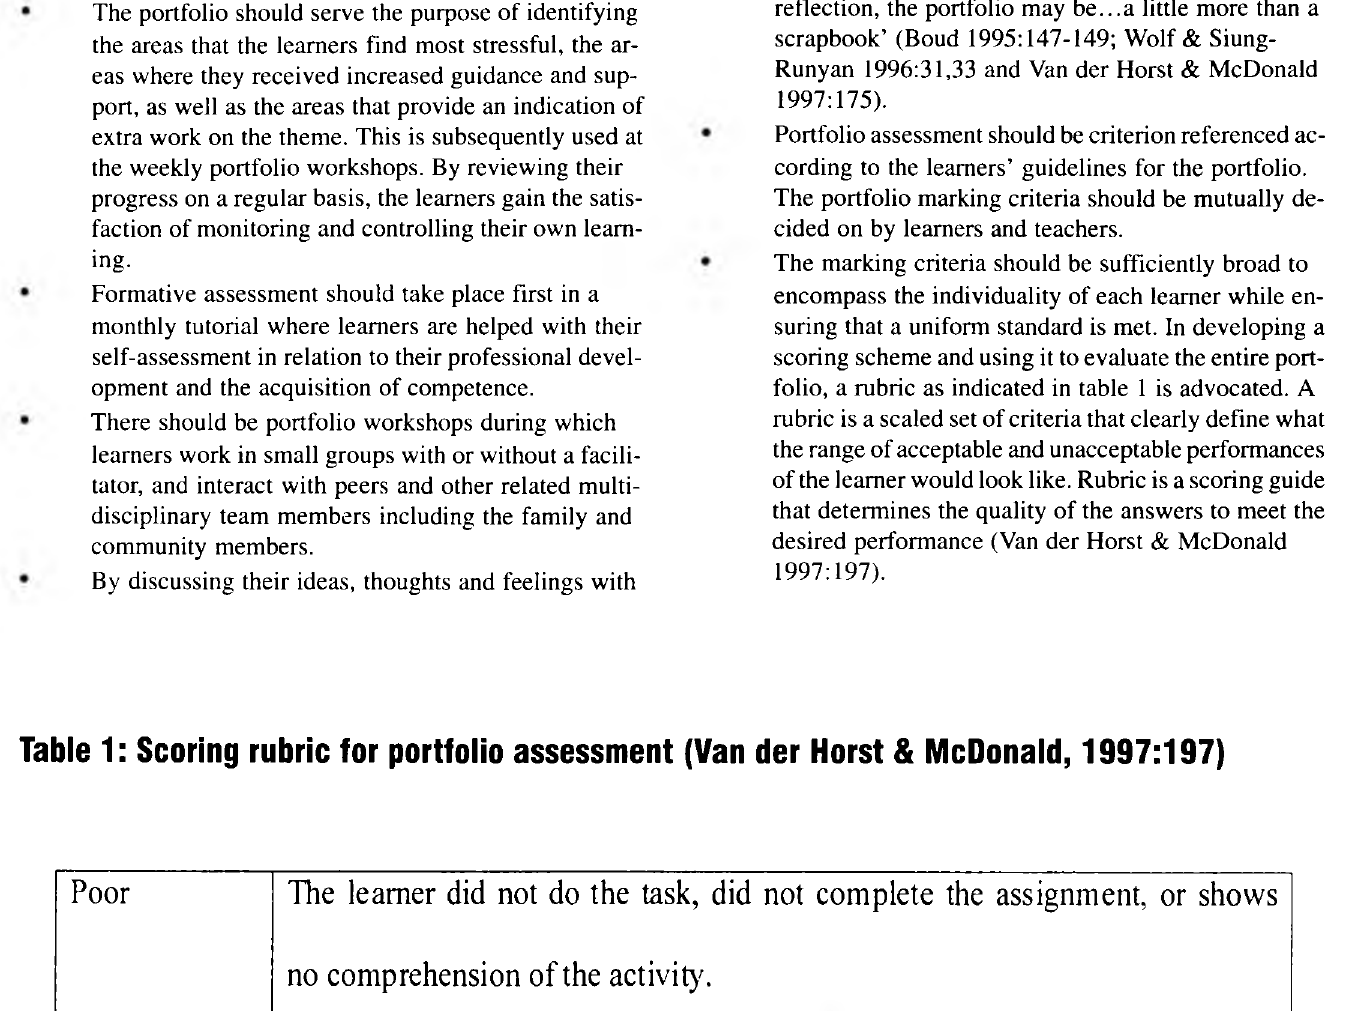
Table 1 : Scoring rubric for portfolio assessment (Van der Horst & M cDonald, 1 9 9 7:1 9 7)